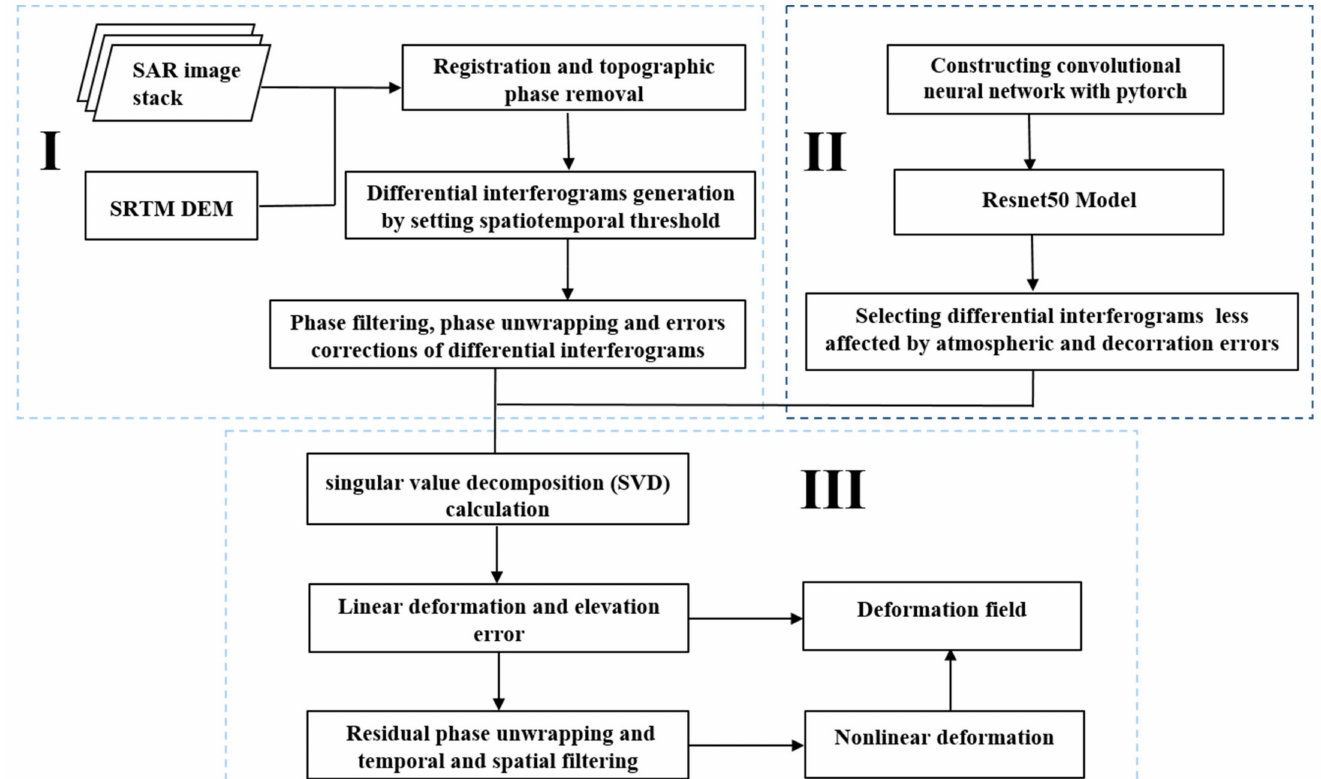
Figure 2. Workflow of the proposed automatic interferogram selection for the SBAS-InSAR algorithm integrated with the DCNN method. ( I ) The calculation of differential interferograms of sequential deformations from SAR images. ( II ) The automatic extraction of high-quality interferograms by the ResNet50–DCNN model. ( III ) The estimation of deformation